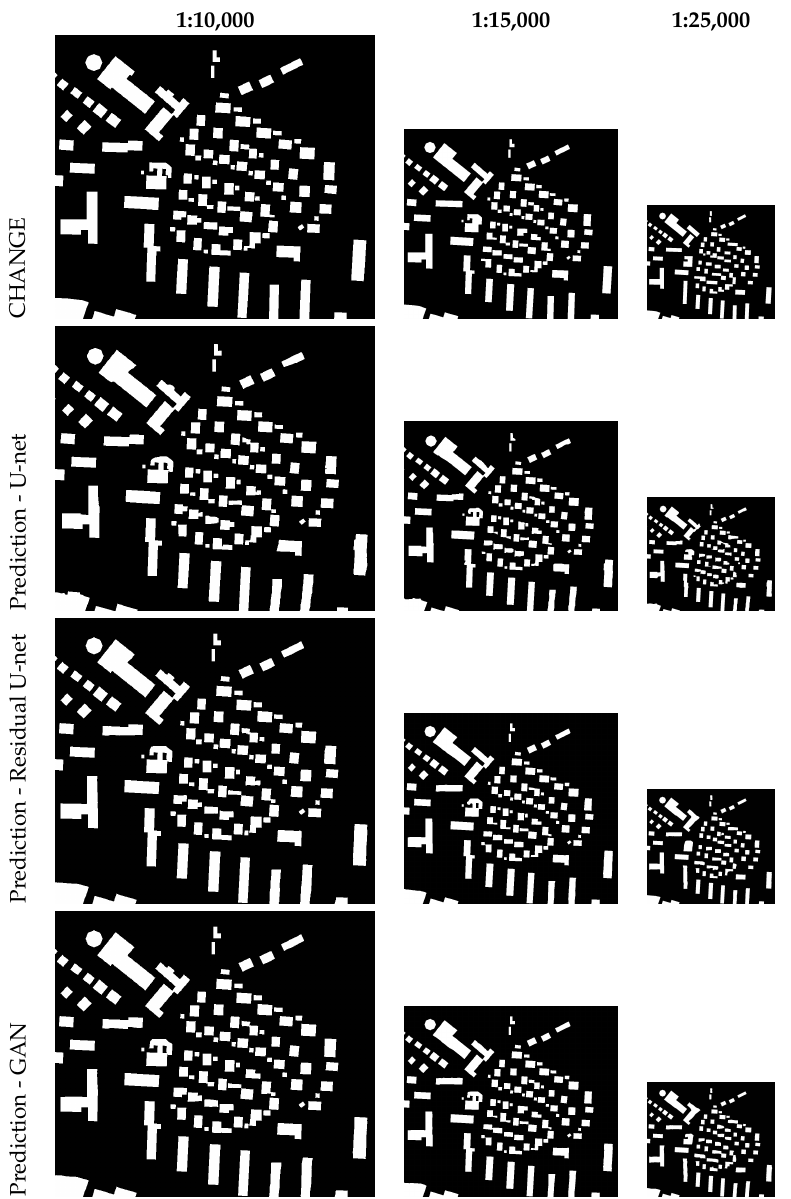
Figure 15. Comparison of building map generalized with CHANGE ( top ) and predicted representation with deep neural networks. Visualization is at the original target scale